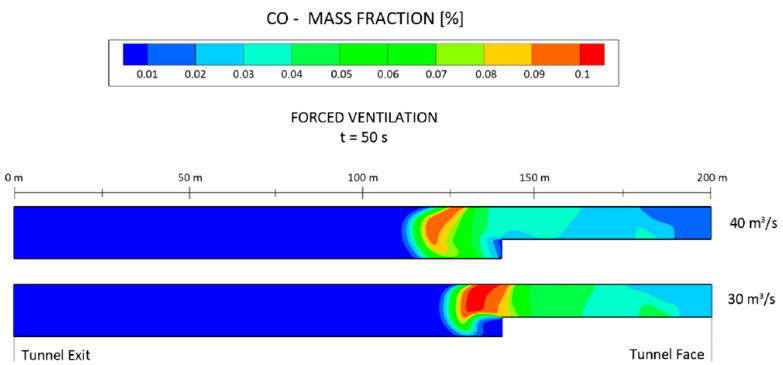
Figure 16. Comparative analysis of the distribution of the CO mass fraction at t = 50 s in the longitudinal central section (X = 0 m) under the forced ventilation mode and airflows of 30 and 40 m 3 s − 1 .